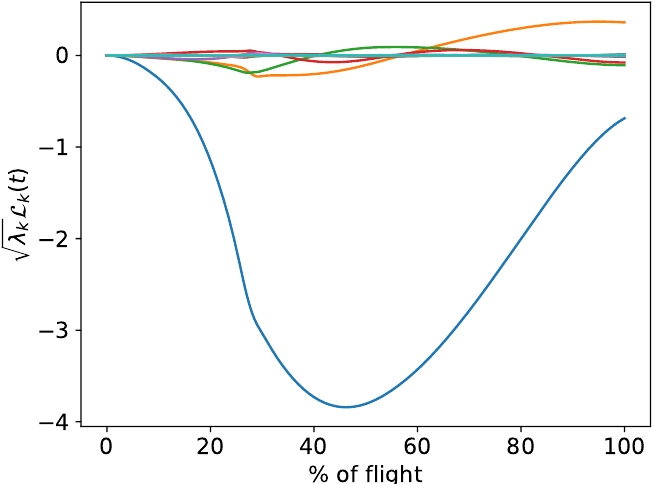
Figure 14. Scaled KL models for the centered